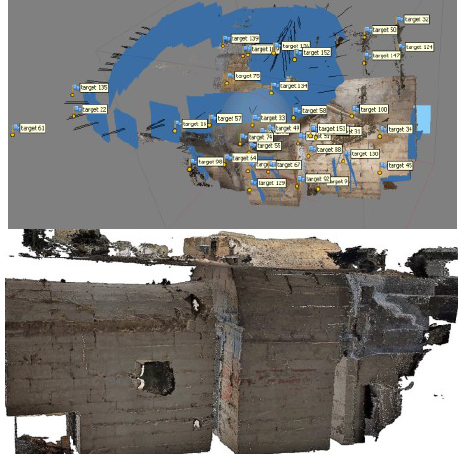
Figure 10: 3D model creation of the Macedonian tomb of Macridy